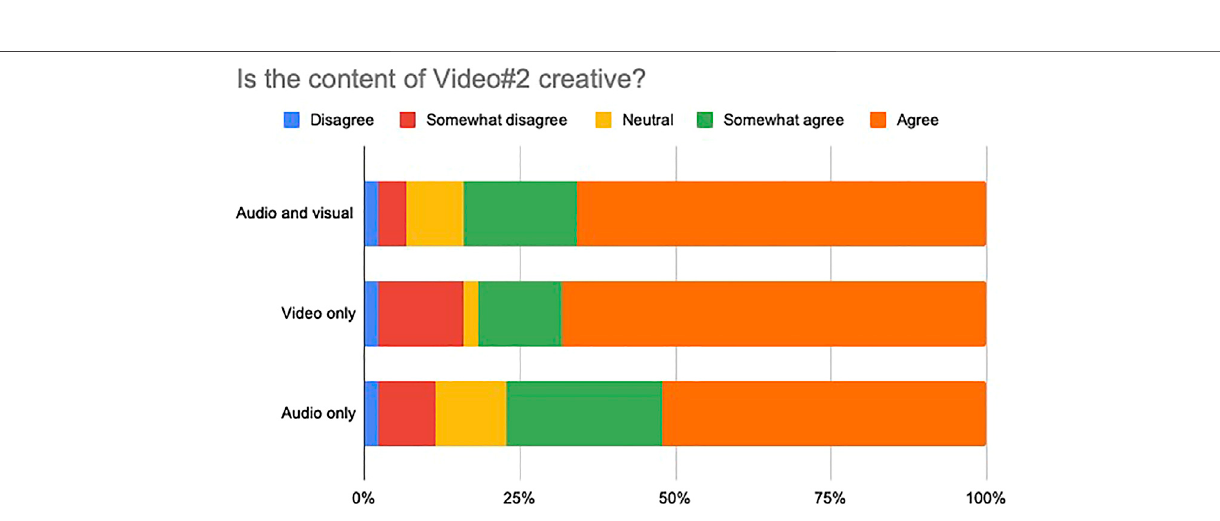
Frontiers in Robotics and AI |